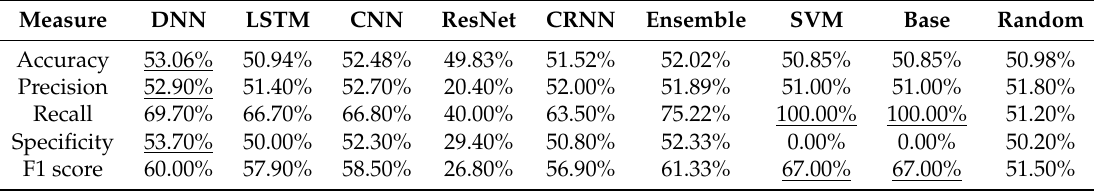
Table 6. Model evaluation under various measures when m = 50. The log values of the major features, the sequential partitioning, and the first value-based normalization were